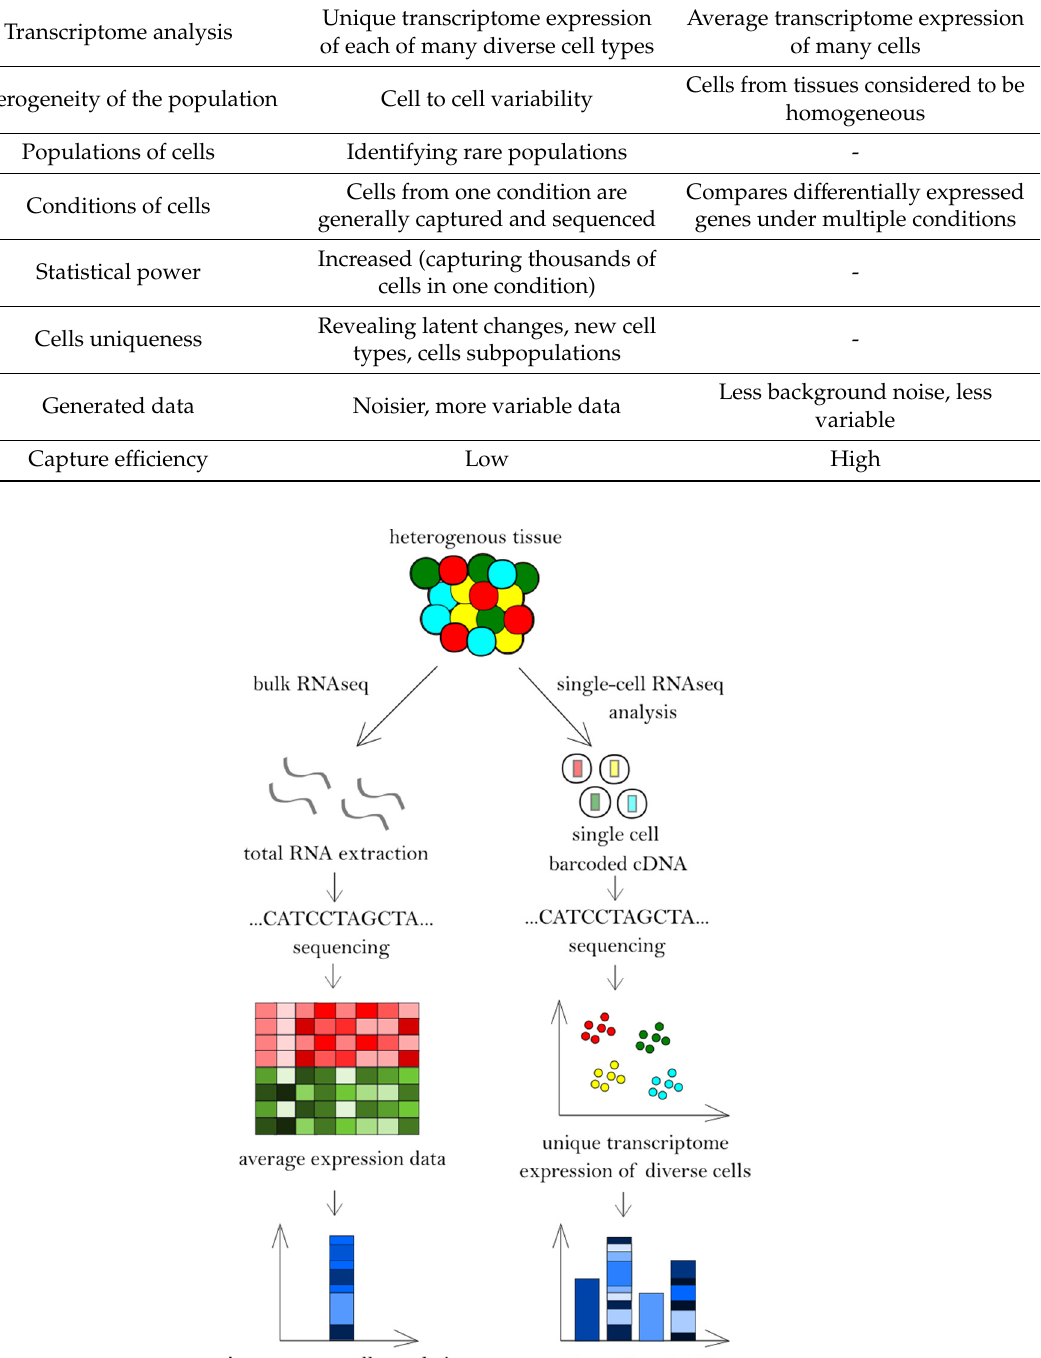
Table 1. Comparison of RNA sequencing methods.